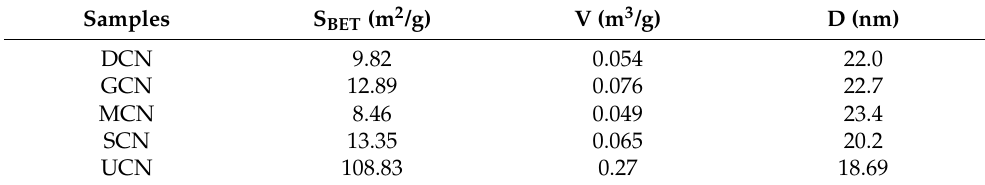
Table 1. Relevant physical parameters from N 2 adsorption/desorption isotherms.